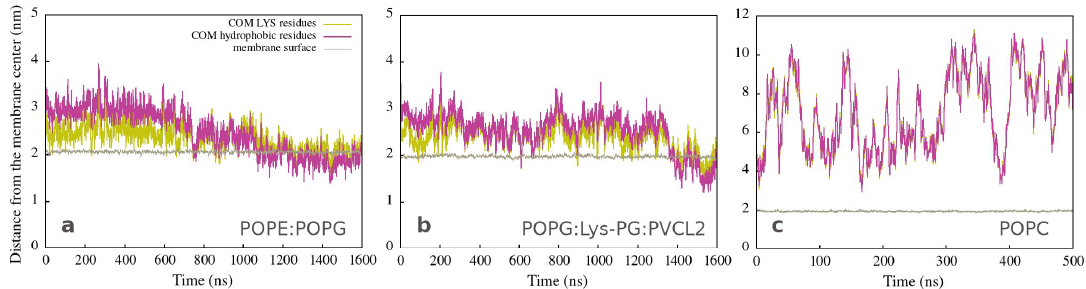
Figure 2. Distances from the membrane center to the COM of LYS (yellow line) and of hydrophobic (magenta line) residues as a function of time for simulations of a single peptide with ( a ) Gram- negative, ( b ) Gram-positive, and ( c ) neutral membranes. The brown line represents the average position of the membrane surface, which is defined as half the membrane thickness (calculated by APL@Voro).